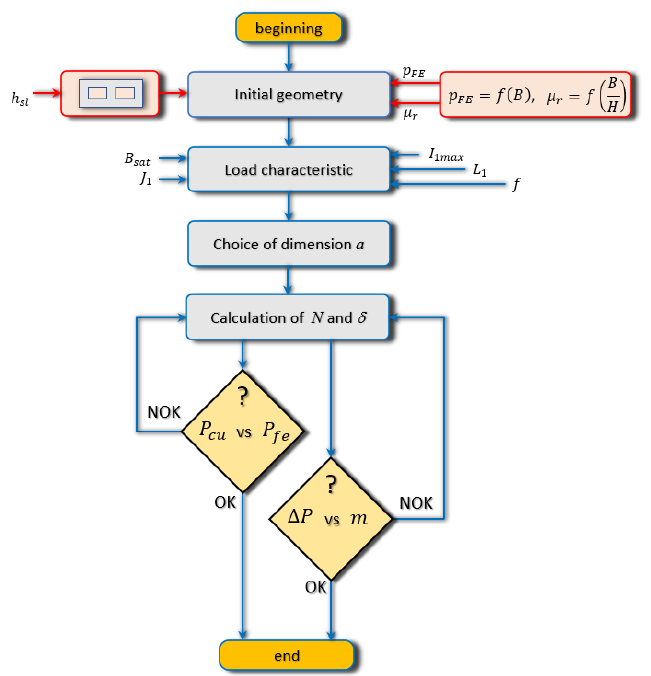
Figure 6. Flowchart of proposed design process.